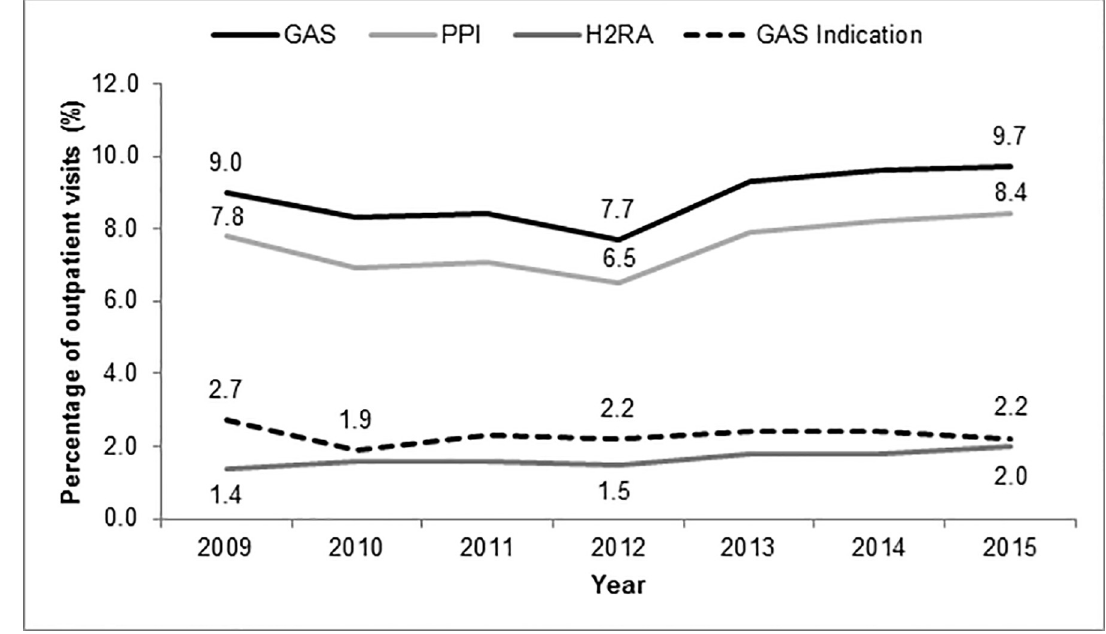
Fig 1. GAS prescribing and indication trends from 2009 to 2015. GAS: gastric acid suppressant; H2RA: histamine-2 receptor antagonist; PPI: proton pump inhibitor.